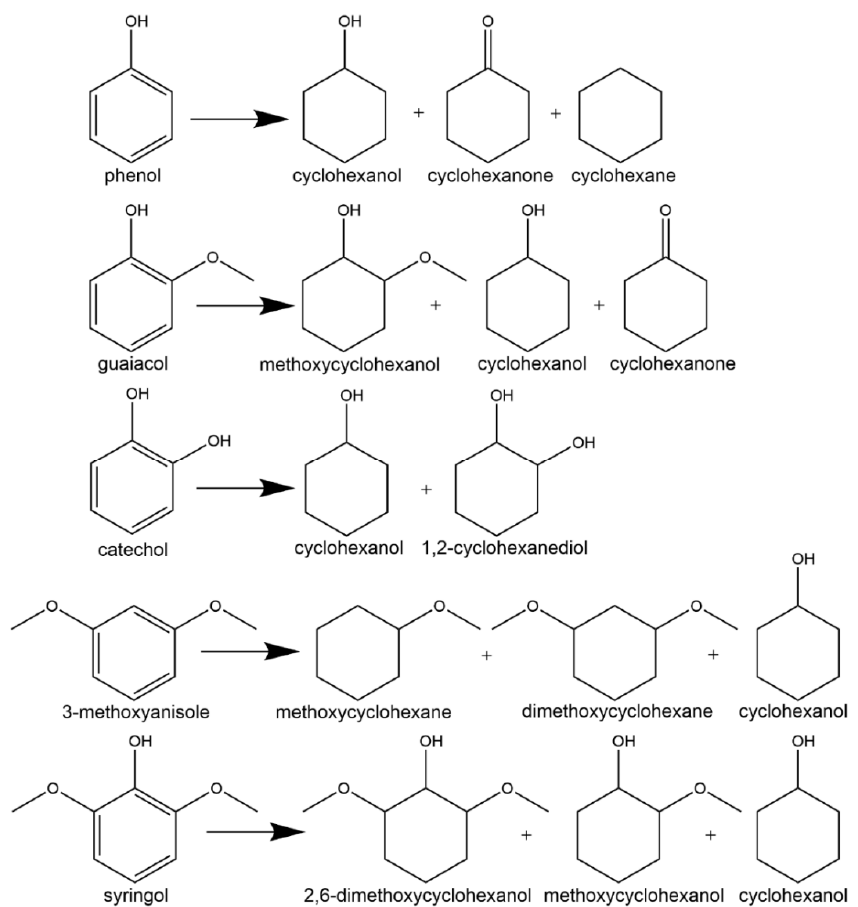
Figure 1. Reaction products observed after ECH of several bio-oil model compounds with different functional groups [47,60]. functional groups